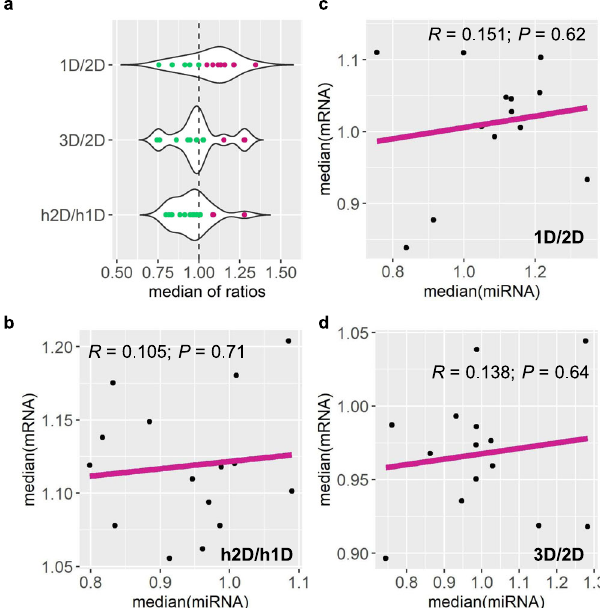
Fig. 1 Relationship between expression of trans genes and trans MIRNAs in each distal aneuploidy comparison. Each data point represents one comparison out of all distal aneuploids assayed. Medians of trans miRNA ratios were computed as in Supplementary Data 5. a Medians of trans miRNA ratios. The x-axis refers to the median of trans miRNA ratios, while the y-axis represents the chromosomal dosage in each comparison. Data points that belong to two clusters produced by the k -means clustering algorithm were painted in different colors. b – d Medians of ratios of trans miRNAs and trans genes in each comparison were plotted on the x- and y- axes, respectively. Medians of trans gene ratios were computed in previous studies 34,35 . R Pearson correlation coef fi cient; P P value for Pearson correlation (two-sided; con fi dence intervals, 95%; no adjustment made for multiple comparisons). Data points with x- and y-axis values exceeding two SDs from the mean are considered outliers, and thus are excluded from the analysis. Source data are provided as a Source Data fi